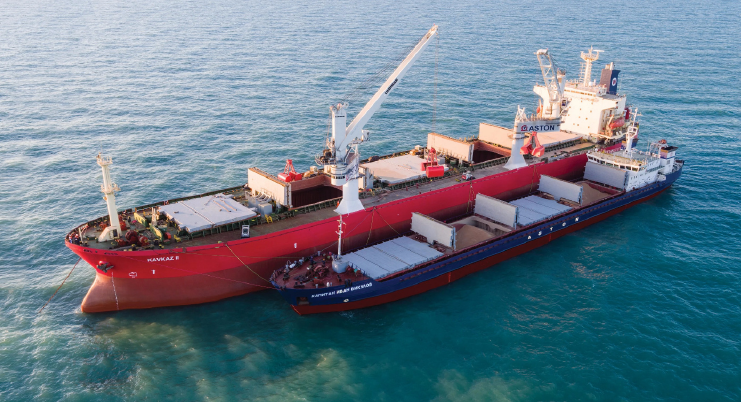
Figure 1. Stevedoring operation with shipboard cranes at